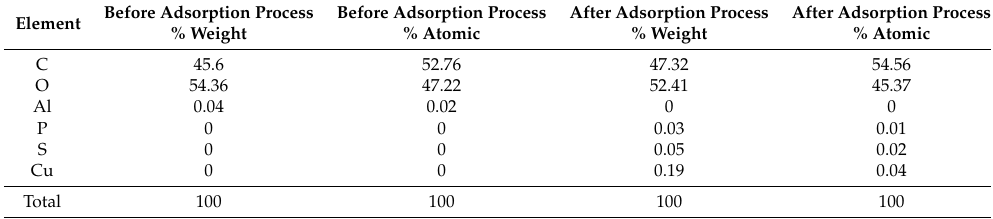
Table 5. Mass percent composition of PVC before and after the adsorption process.